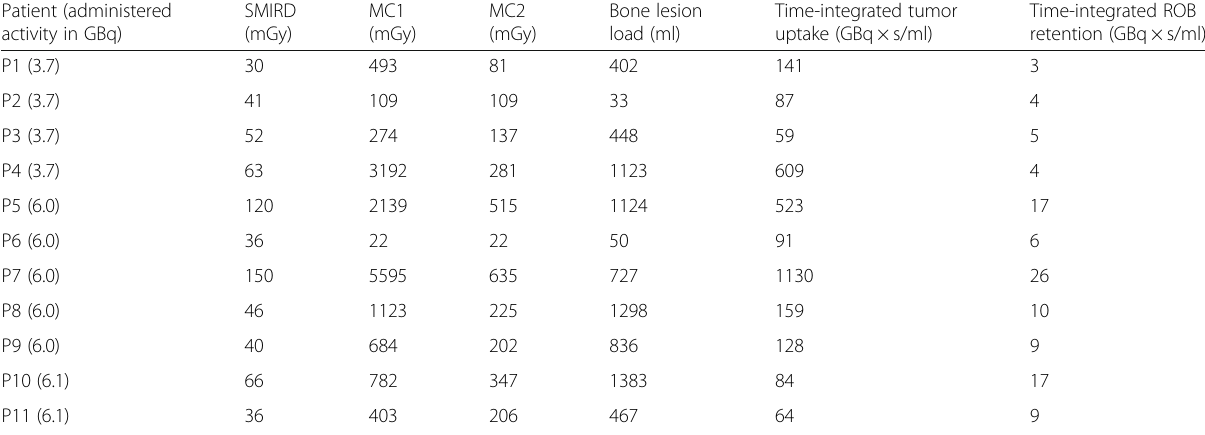
Table 2 Bone marrow absorbed dose estimates as derived either using S values (SMIRD), Monte Carlo simulations under the assumption of a physiological active bone marrow distribution (MC1), or Monte Carlo simulations assuming no active bone marrow at the direct location of the bone lesions (MC2)